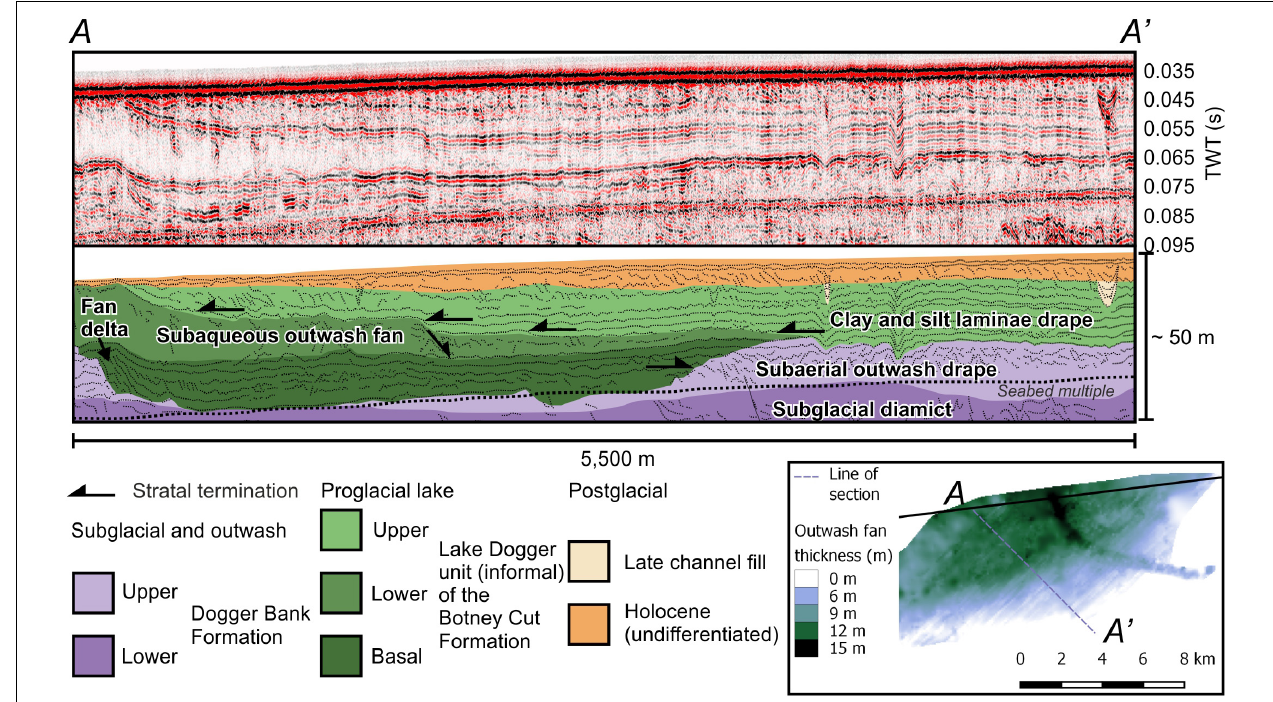
FIGURE 5 | Stratigraphic section showing the proglacial lake stratigraphic relationships. Inset: Isopach map of the Lower Lake Dogger sub-unit showing its lobate geometry, thinning toward the east and